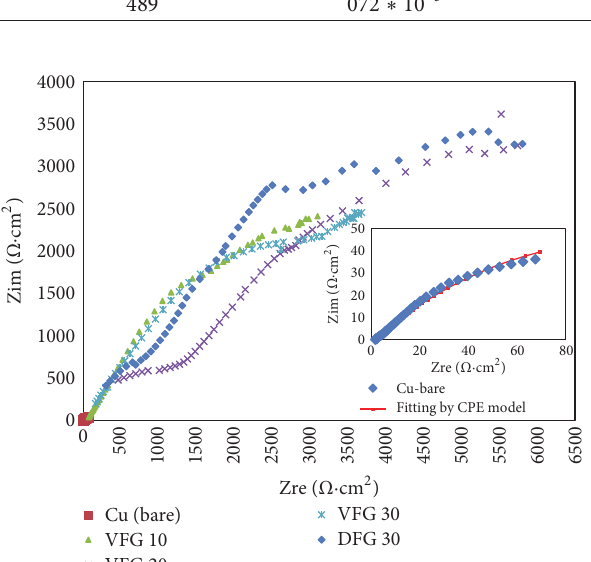
Figure 7: Nyquist plots for copper substrate and the superhydrophobic surfaces prepared with different degrees of fluorination and modification techniques in 3.5 wt.% NaCl solution.